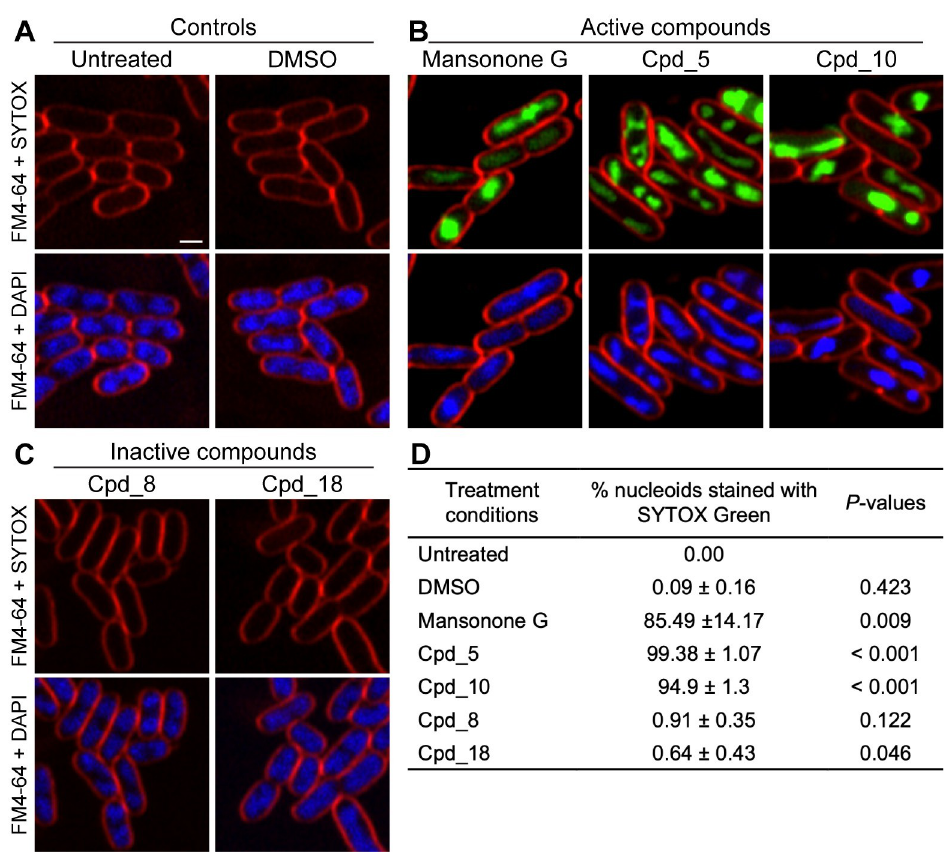
Fig 2. Mansonone G and its derivatives showing membrane permeabilizing activity in E . coli lptD4213. E . coli lptD4213 cells were treated for 120 minutes with compounds and then stained with 2 μ g/ml FM4-64 (red), 4 μ g/ml DAPI (blue) and 0.5 μ M SYTOX Green (Green). Upper panels show FM4-64 and SYTOX Green while lower panels show FM4-64 and DAPI, for treatment conditions; (A) untreated control and 0.25% v/v DMSO-treated control, (B) active compounds at 2x MIC– 250 μ M mansonone G, 62.5 μ M Cpd_5, 31.25 μ M Cpd_10 and (C) inactive compounds Cpd_8 and Cpd_18 at 250 μ M. Scale bar represents 1 μ m. (D) Table showing the percentage of nucleoids whose SYTOX intensities are more than 3 times the mean SYTOX intensity of the untreated control. P -values are from two- tailed Student’s t-test from pair-wise comparison between each condition and untreated control, n = 3.